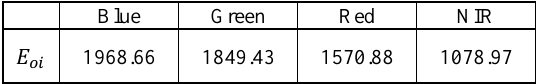
Table 2. 𝐸 𝑜𝑖 for WFV1 camera